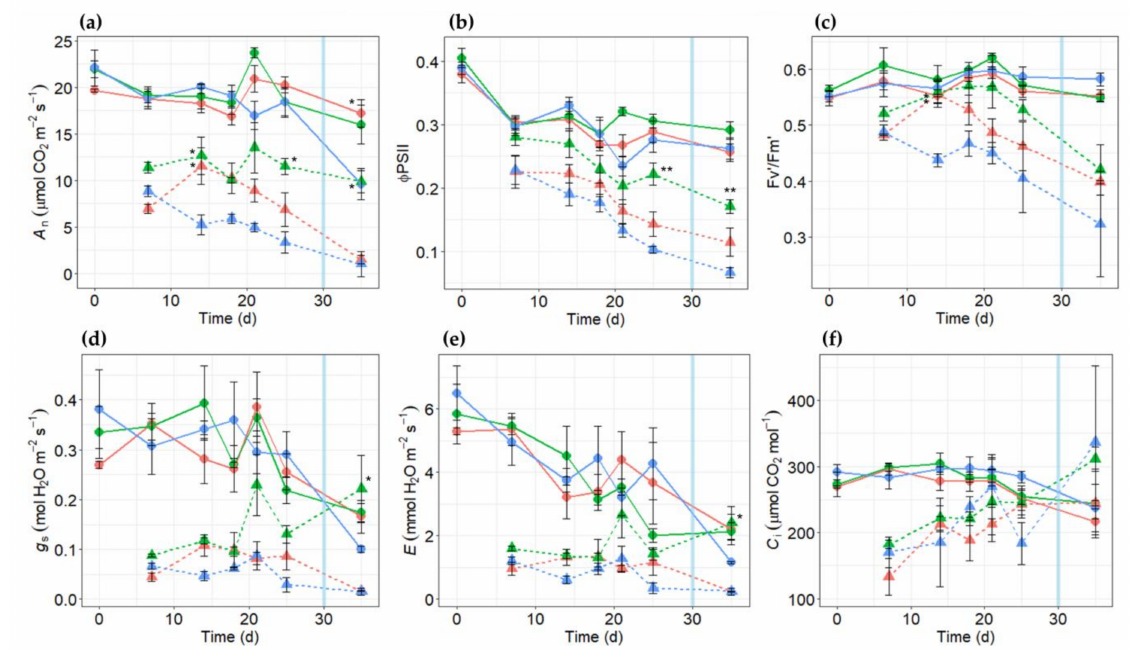
Figure 5. Gas exchange in faba bean PR10a transgenic lines; TL-3 (green), TL-2 (red), and wild-type (blue) under non- stressed (circular symbols and solid lines) and under salt stress conditions (triangle symbols and dashed lines) on days 7, 14, 18, 21, and 25 from the salt application. The salt was removed on day 30 (light blue line). ( a ) Net photosynthetic rate A n , ( b ) quantum efficiency of photosystem II electron transport under 1200 µ mol m − 2 s − 1 PAR ( φ PSII), ( c ) maximum efficiency of photosystem II photochemistry in the light Fv’/Fm’, ( d ) stomatal conductance g s, ( e ) transpiration rate E and ( f ) intercellular CO 2 concentration C i . Data points represent means ( ± SE) of at least four